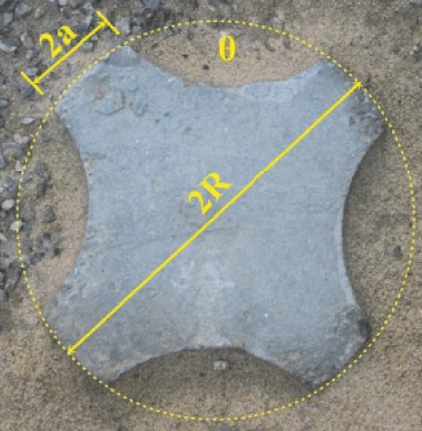
Figure 1: Cross-section of a constructed X-section pile.